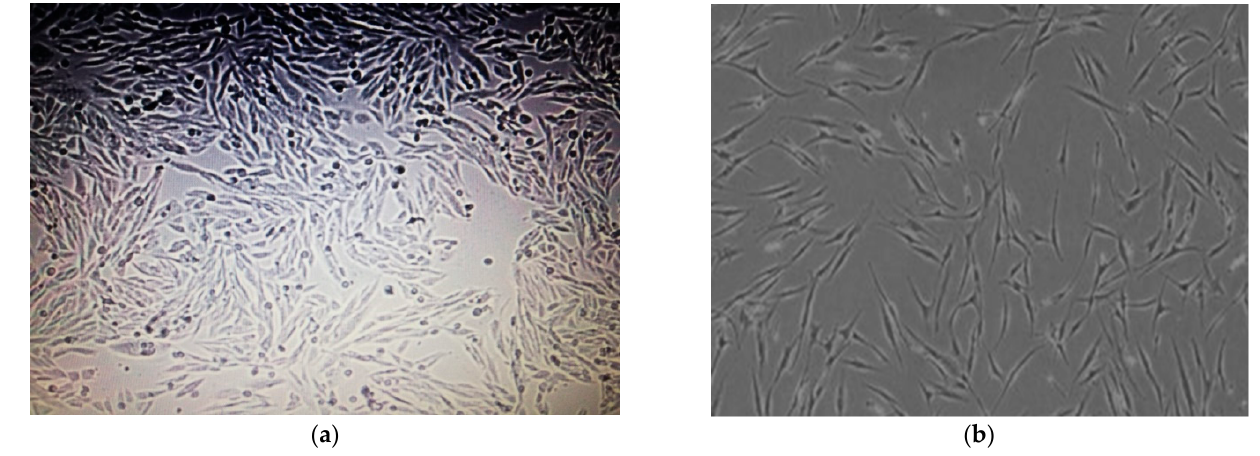
Figure 7. ( a ) Microscopic image of HUVEC cells after 72 h before exposure to NP doses. Cells are well developed and confluent. ( b ) Microscopic image of HUVEC cells after exposure to NP dosing. Reduced cell viability and less confluence are apparent after dosing.